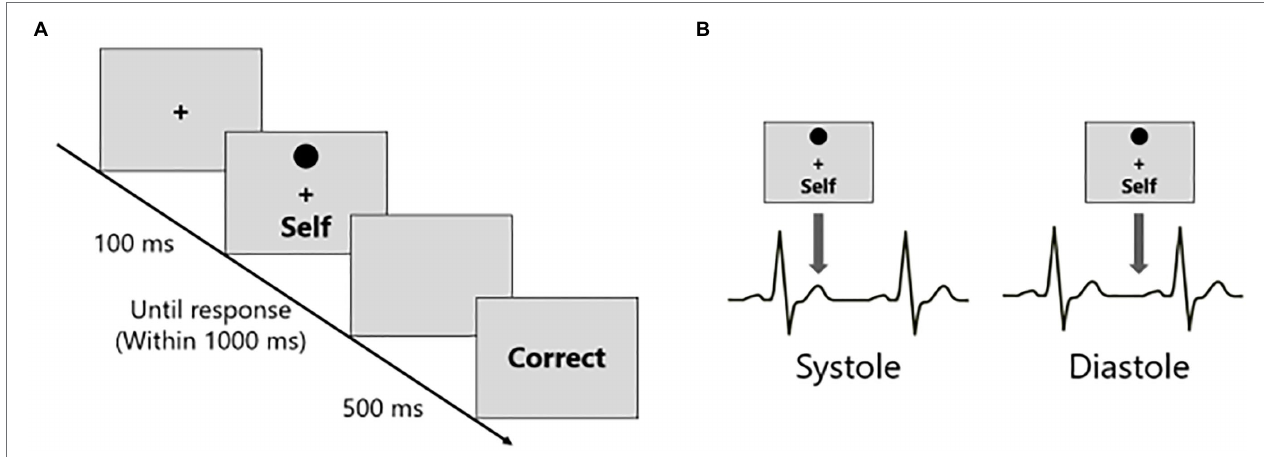
FIGURE 1 | The procedures of the matching phase and the timings of stimuli presentations in the shape-label matching task. (A) The participants judged whether the presented shape-label pair was matched based on the associations learned during the learning phase. (B) The shape-label pairs were presented in coincidence with either systole (T-wave peak) or diastole (T-wave peak + 250 ms) in the participant’s cardiac